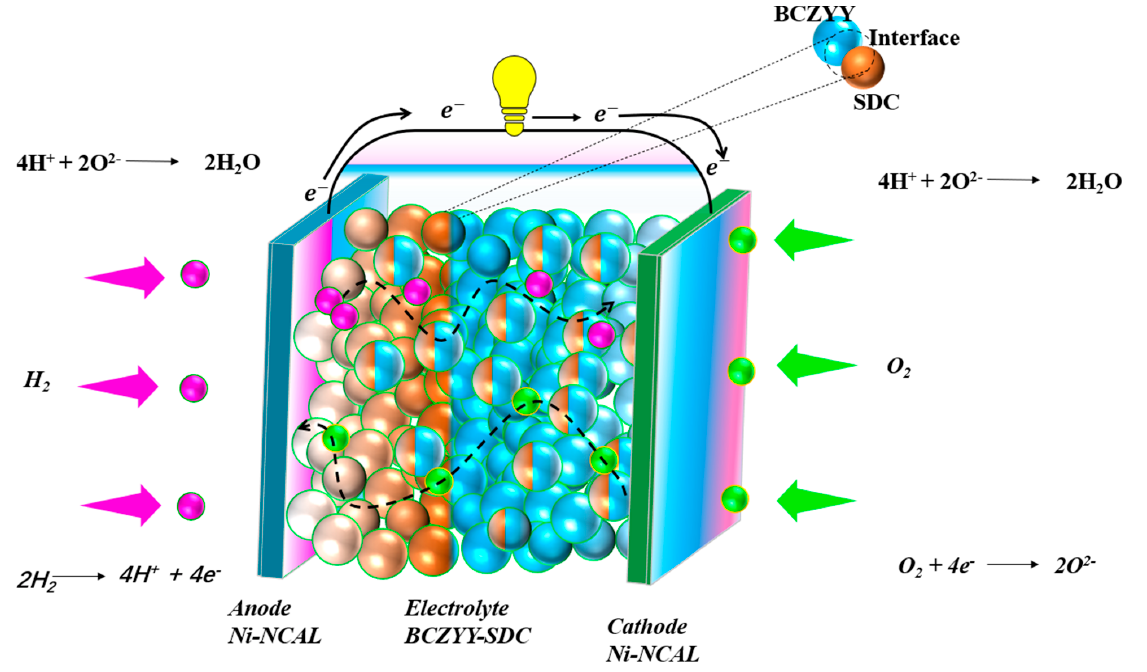
Figure 8. The different electrochemical mechanisms and processes involved fuel cells with BCZYYb- SDC electrolyte-based fuel cells for ionic transport.